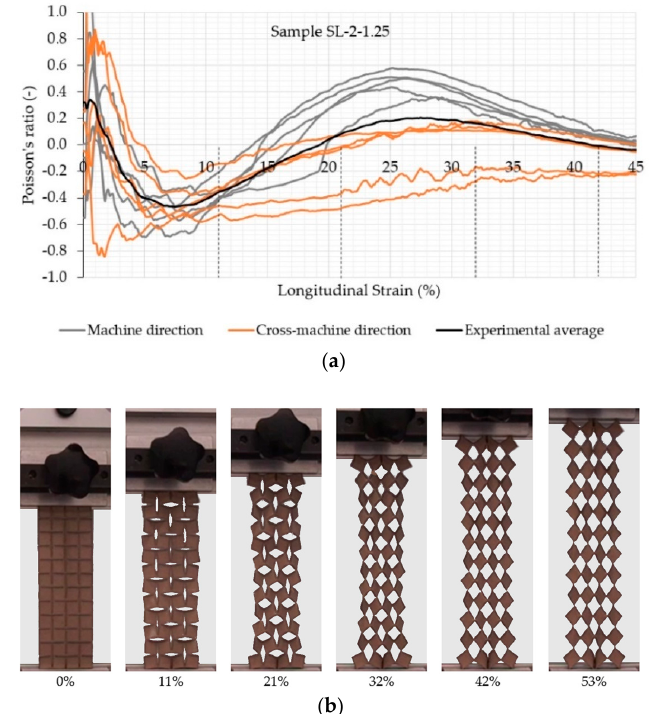
Figure 7. ( a ) Evolution of the Poisson’s ratio with the longitudinal strain of the auxetic sample SL-2-1.25 and ( b ) fabric deformation at di ff erent longitudinal strains during tensile testing in the machine